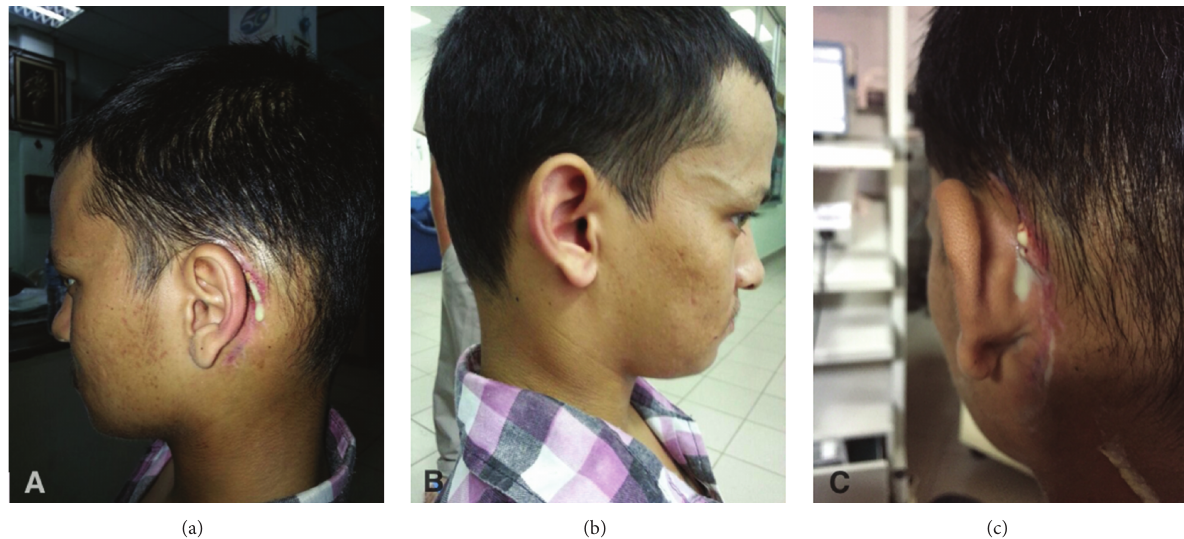
Figure 1: (a and c) Wound dehiscence of the left mastoidectomy site discharging pus. (b) Right neck fullness.